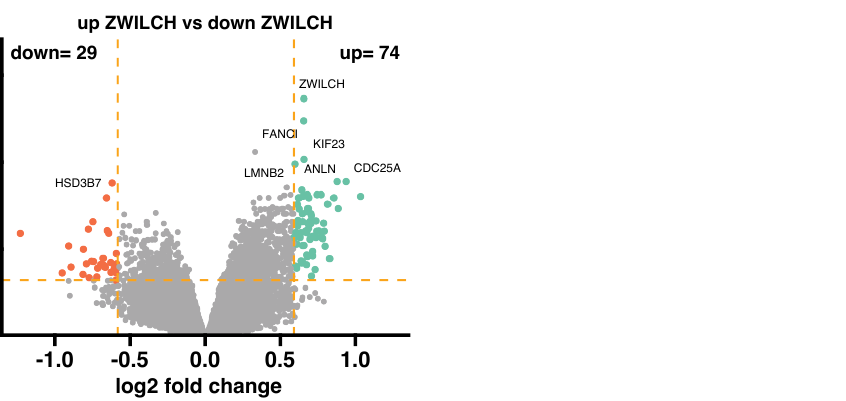
Figure 5. General transcriptome profile in groups of 10 patients with the highest expression of the ZWILCH gene (up ZWILCH ) compared to 10 patients with the lowest expression of the ZWILCH gene (down ZWILCH ) (data from GSE10927). Each dot on the graph represents the mean value of the gene expression level of ten patients belonging to a particular group. The cut-off criteria for identifying differentially expressed genes were established as |fold change| = 1.5 and p -value = 0.05, and are represented by orange dotted lines. Genes above the cut-off lines were categorized as up − regulated (green dots) or down − regulated (red dots). The total number of up − and down − regulated genes can be found in the top right and top left corners, respectively. The plots also indicate the symbols for the seven most differentially expressed genes.